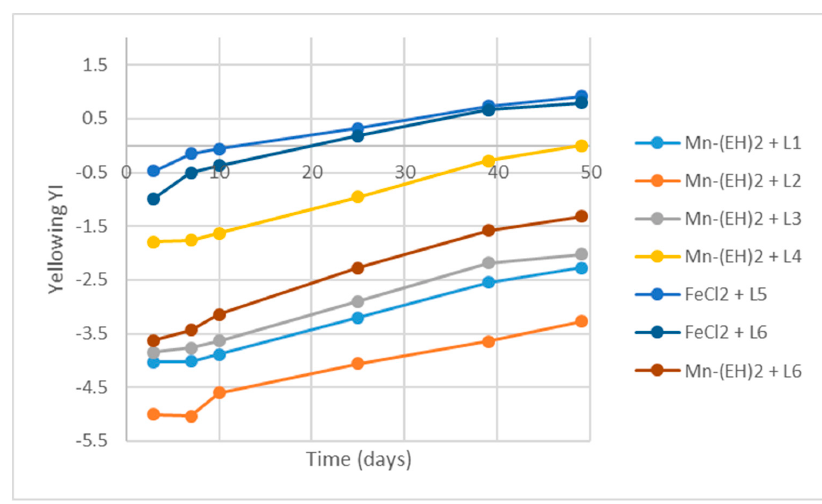
Figure 17. Yellowing data in a commercial white alkyd formulation (without optimization using, i.e., secondary and sacrificial siccatives).